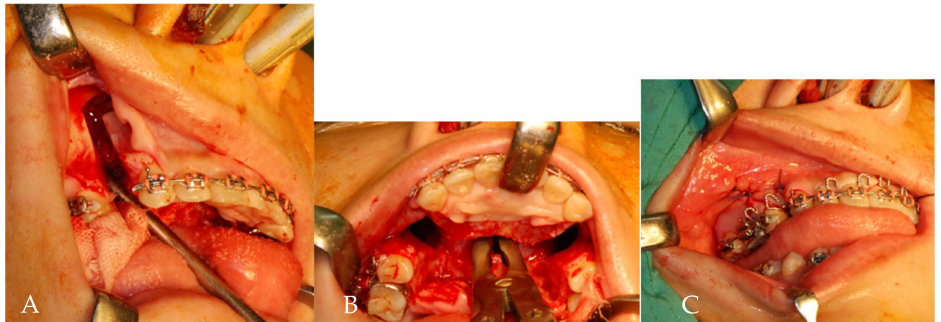
Figure 3. ( A ) Buccal ostectomy of lateral maxilla through retracted wound margins. ( B ) An anterior curving transpalatal ostectomy was performed to connect bilateral buccal ostectomy sites. A rongeur forcep was used to remove a small portion of nasal septum. ( C ) A predetermined palatal acrylic splint fixed with anterior and posterior teeth by circumdental